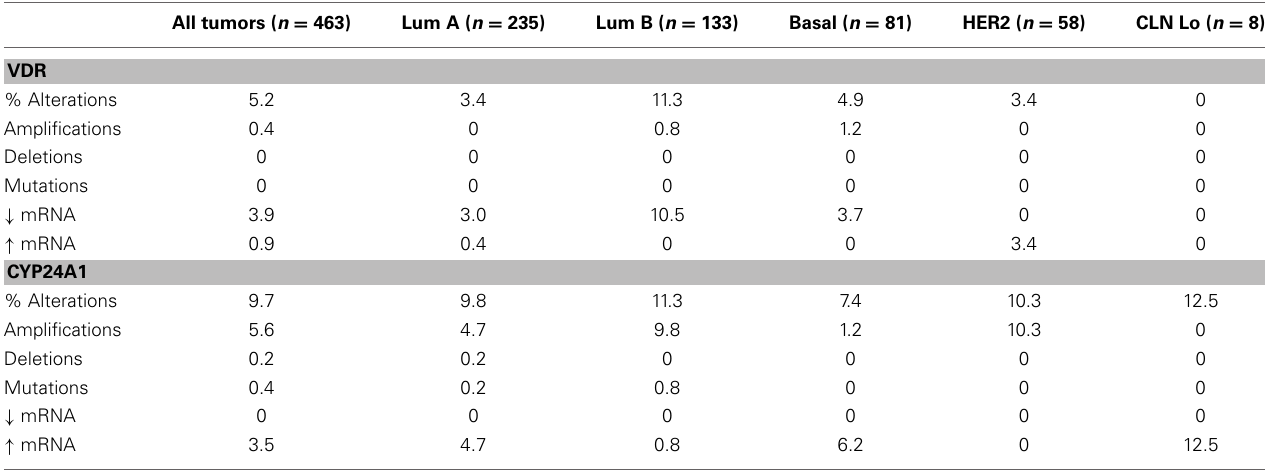
Table 1 | Frequency of genomic alterations in VDR and CYP24A1 derived from The Cancer Genome Atlas dataset of human breast tumors. All tumors ( n =